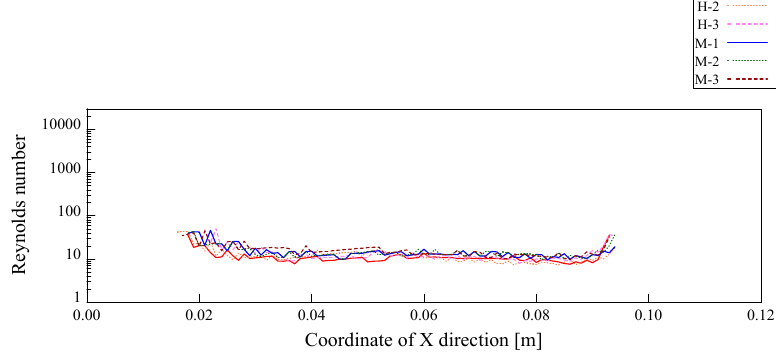
Figure 14. Relationship of Froude numbers in each cross section from M-1.